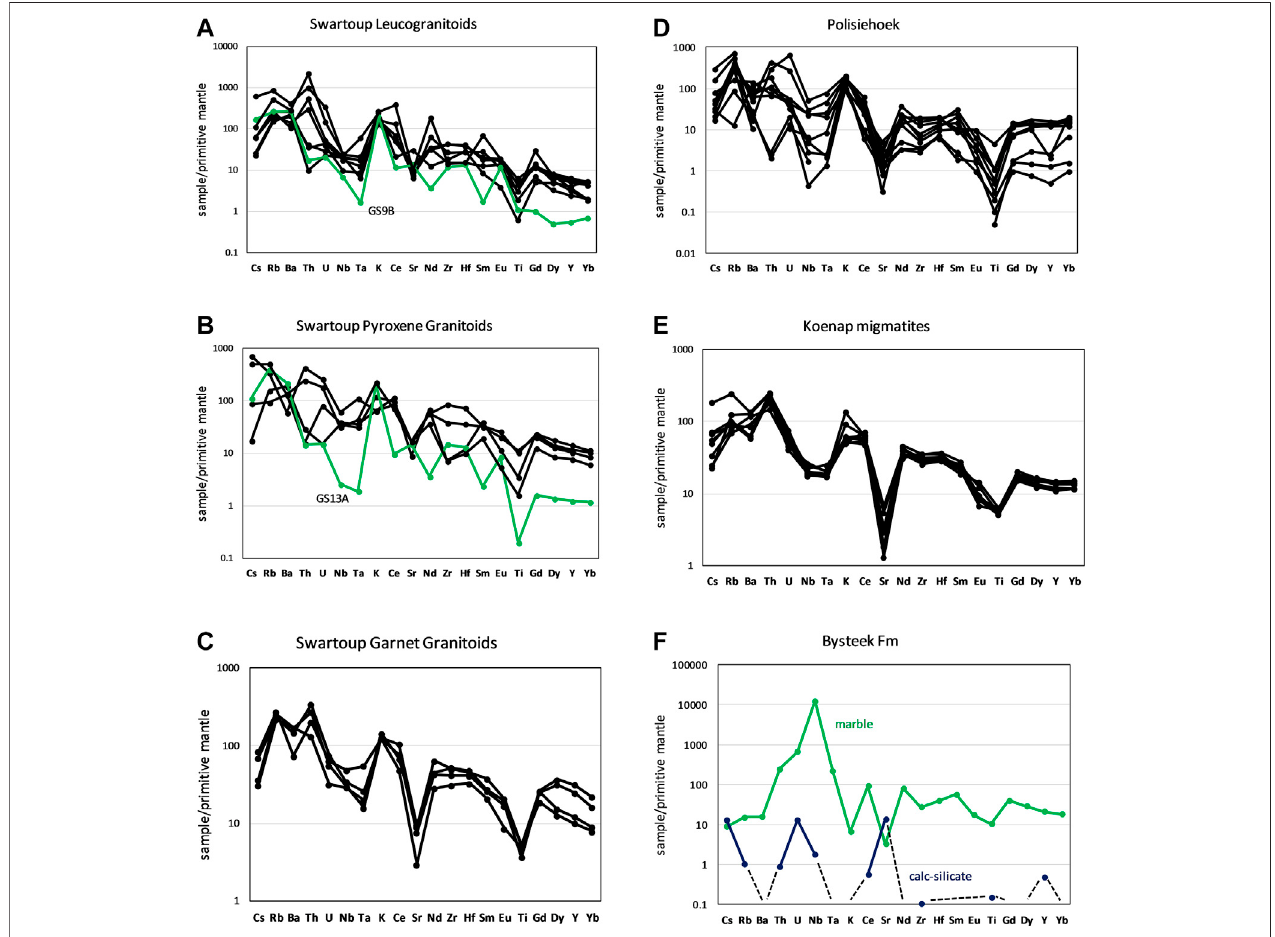
FIGURE 5 | Incompatible element spidergrams, normalized to Primitive Mantle (Bulk Silicate Earth pyrolite) of McDonough and Sun (1995). See text for additional information.